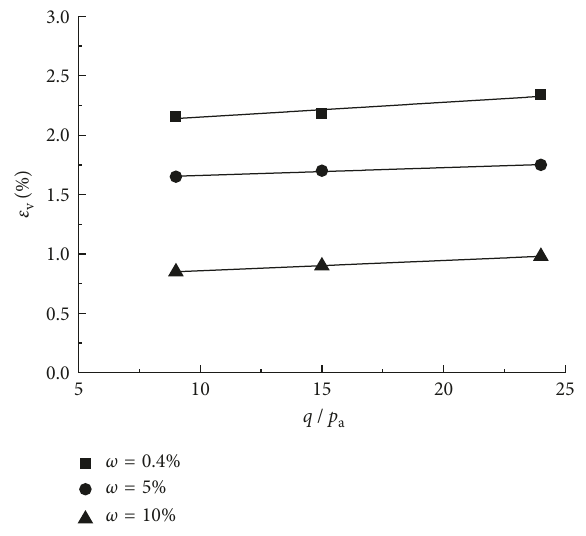
Figure 15: q / p a versus ε v curve (different initial water content conditions).